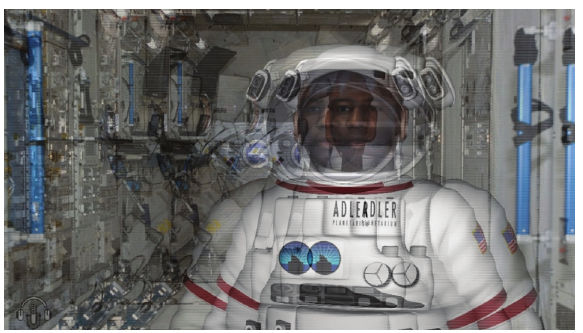
Figure 25. Stereoscopic Rendering Image Using Interlaced